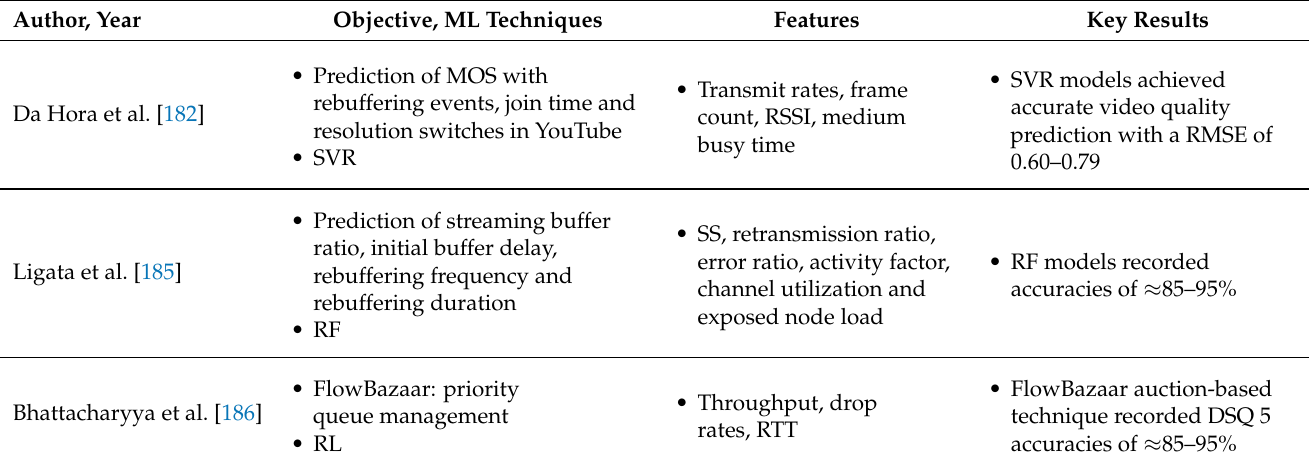
Table 6. Summary of video quality prediction in wireless